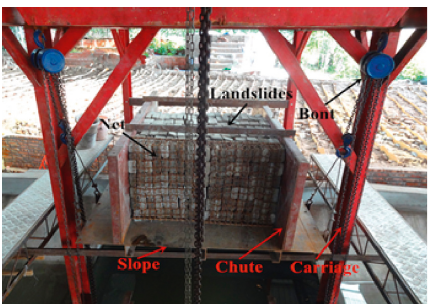
Figure 1: Arrangement of sliding